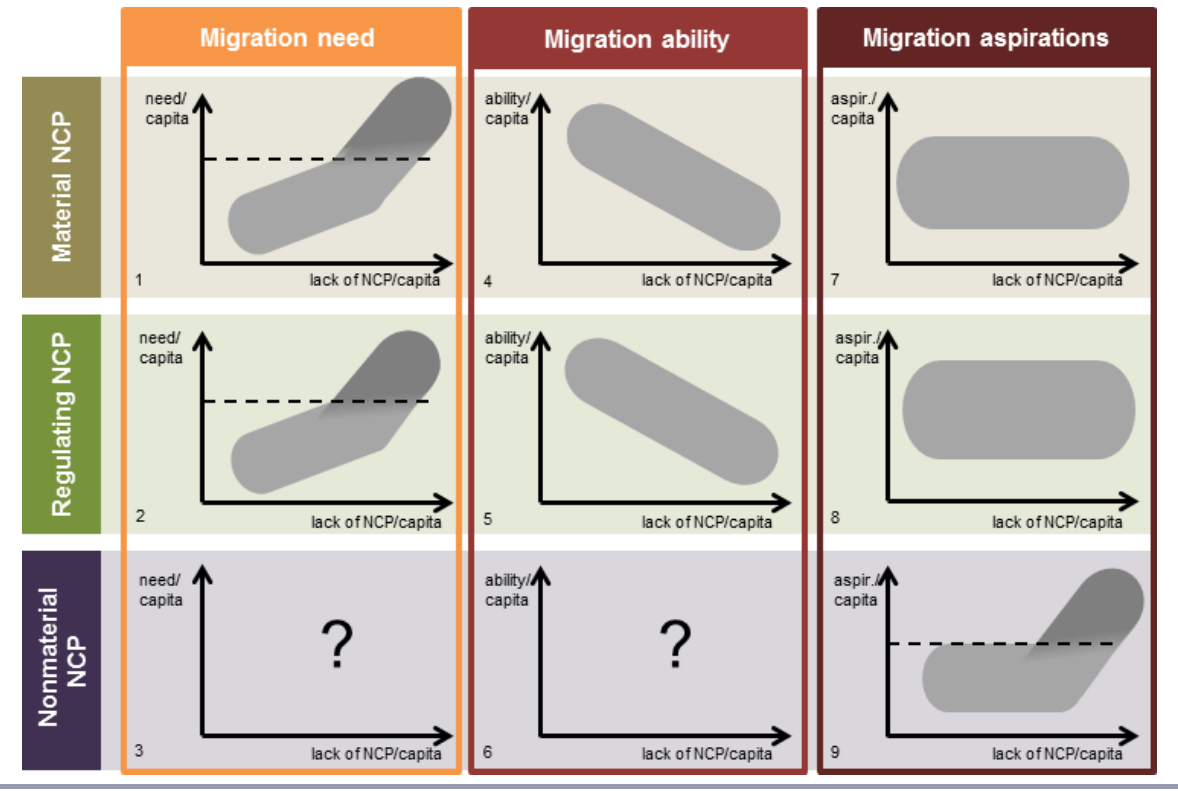
Fig. 3 . Hypothesized “direction” of the linkages between nature’s contributions to people (NCP)/capita and migration need, ability, and